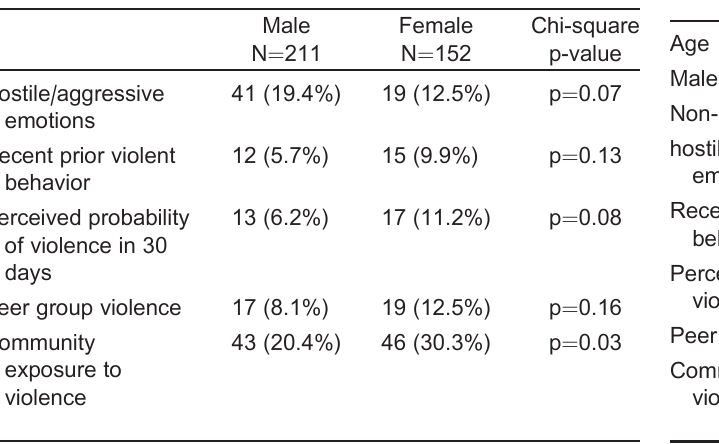
Table 3. Rates of high exposure to specific violence risk factors as associated with patient gender.